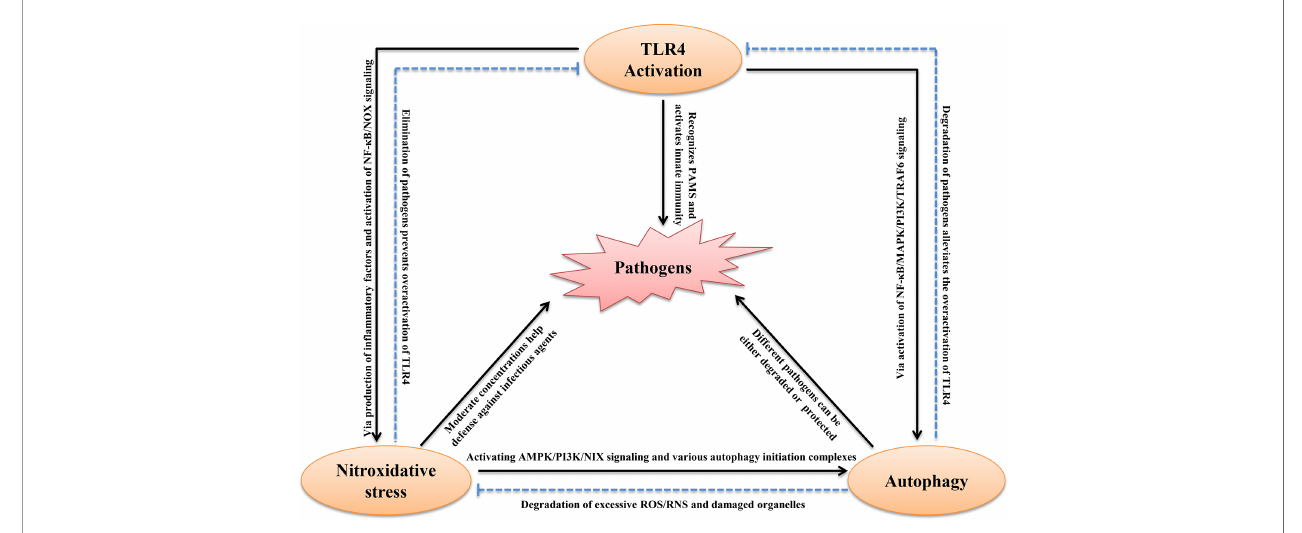
FIGURE 2 | Schematic diagram of the interplay between TLR4, autophagy and nitroxidative stress in infectious Diseases. See text for